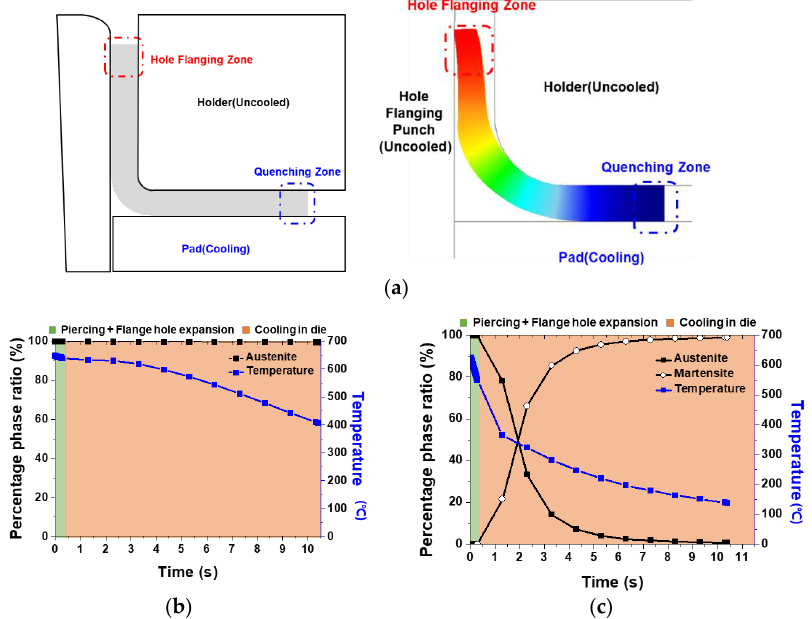
Figure 6. Change in phase distribution with respect to position during the piercing and hole-flanging process; ( a ) mea- surement positions of temperature and phase distribution; ( b ) percentage phase distribution at hole flanging zone; ( c ) percentage phase distribution at quenching